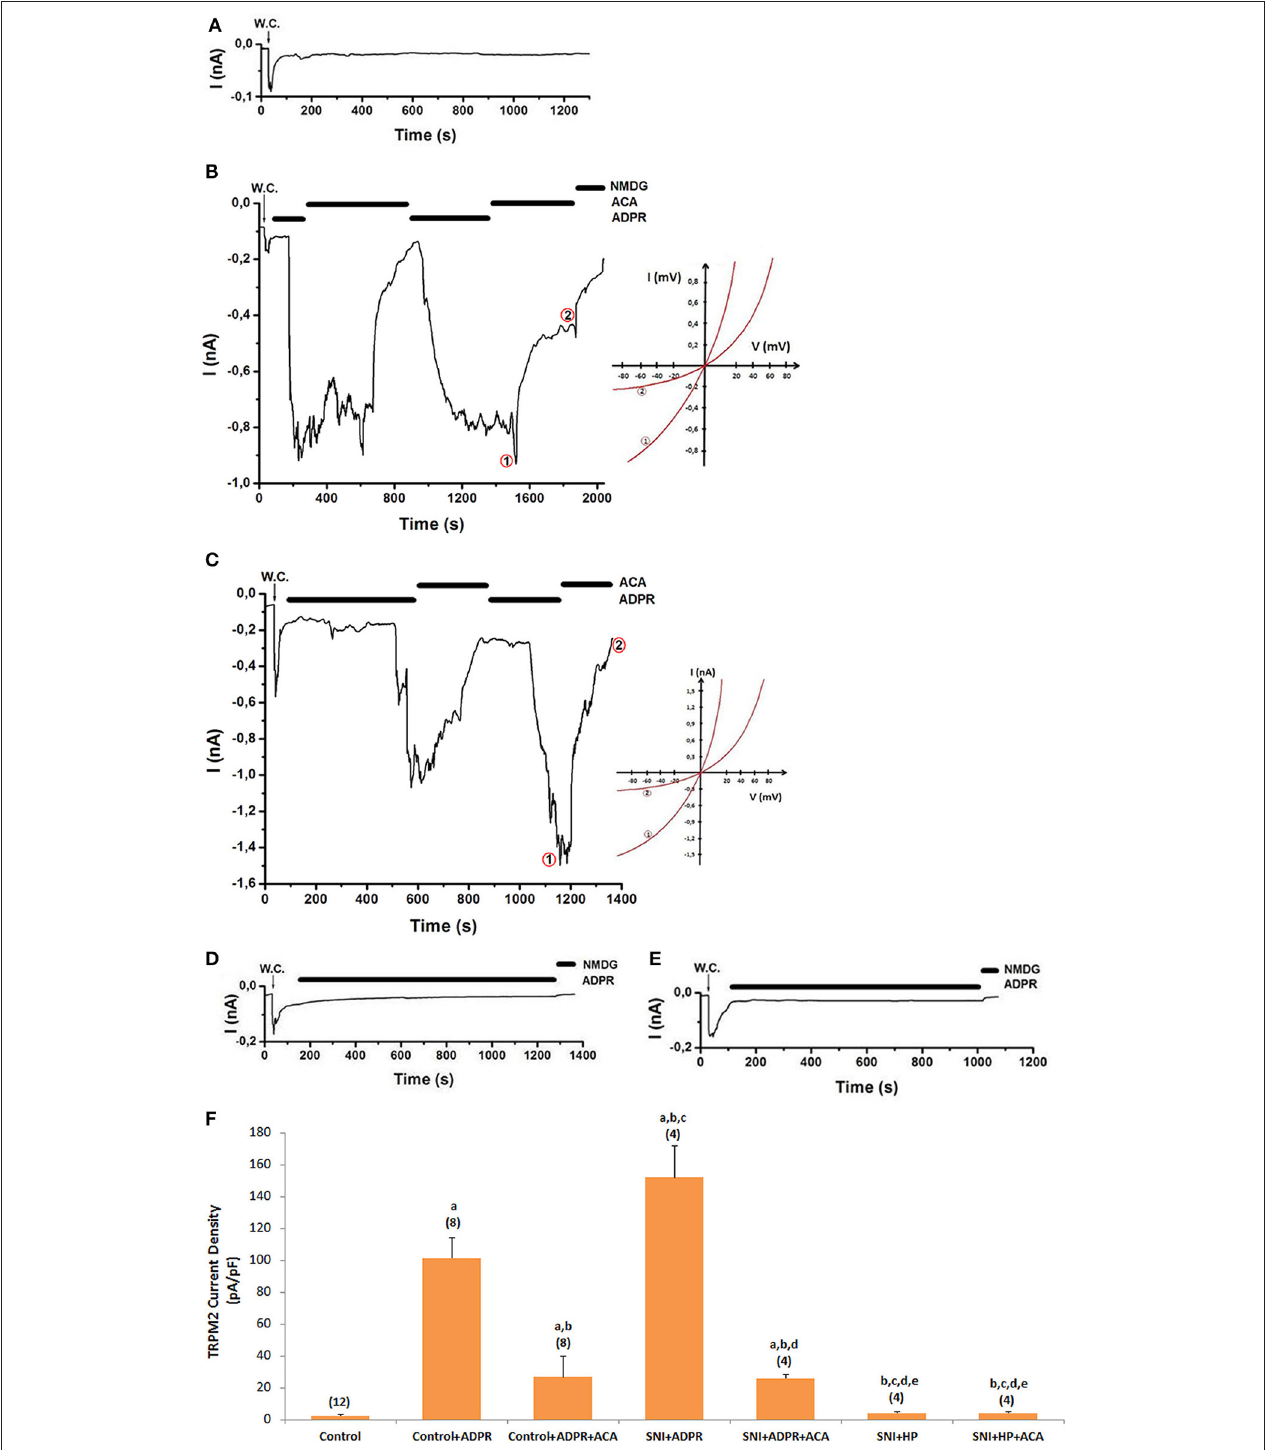
FIGURE 4 | Effects of HP on TRPM2 channel activation in dorsal root ganglion neuron (DRGN) of control and SNI-induced rat. The TRPM2 currents in DRGN were stimulated by intracellular ADPR (1 mM in patch pipette) but they were inhibited by extracellular ACA (0.025 mM) in the patch-chamber. W.C.: Whole cell. Control (without SCI induction and stimulation): Original recordings from control neuron (A) . (B) . Control + ADPR group (without SCI induction). (C) . SNI group (with SCI induction). (D) . SCI + HP group: The rats received HP after SCI induction. (E) . HP group: The rats received HP without SCI induction. (F) . TRPM2 channel current densities in the DRGN. The numbers in parentheses indicated n numbers of groups were indicated by numbers in parentheses. ( a p ≤ 0.001 vs. control. b p ≤ 0.001 vs. control + ADPR group. c p ≤ 0.001 vs. control + ADPR + ACA group. d p ≤ 0.001 vs. SNI + ADPR group. e p ≤ 0.001 vs. SNI + ADPR + ACA group).